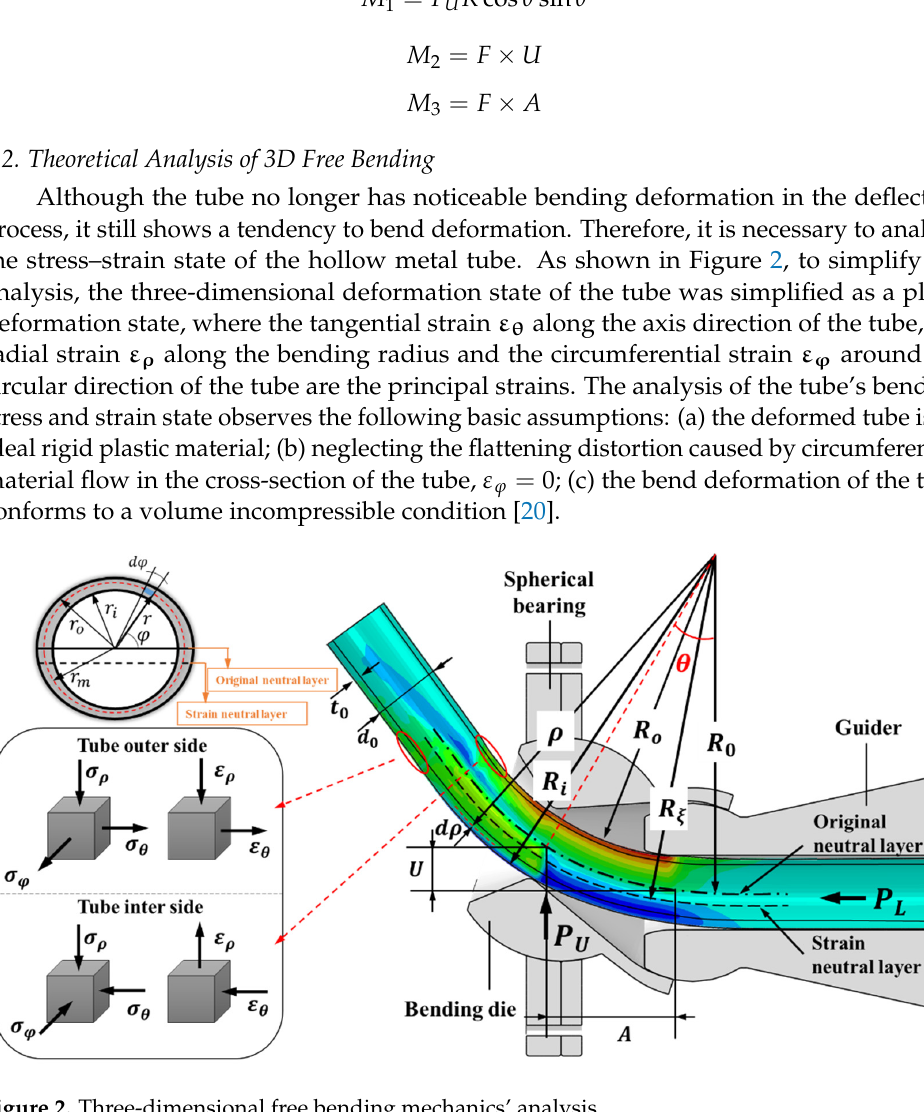
Figure 2. Three-dimensional free bending mechanics’ analysis.